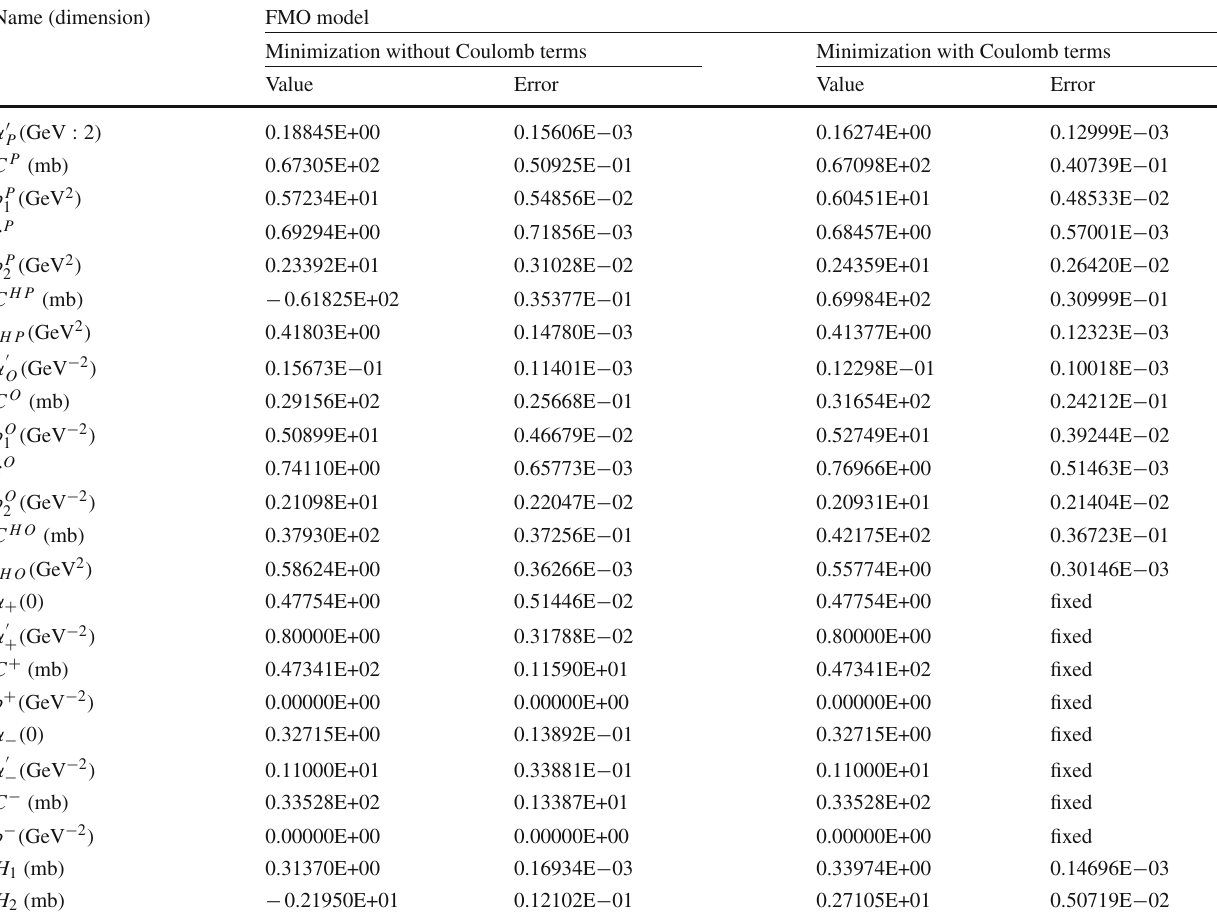
Table 3 Parameters of standard Pomeron and Odderon, of their double rescatterings, of secondary Reggeons and their errors in FMO model determined from the fits to the data on d σ/ dt . Total cross sections σ tot and ratios ρ were included in the fit without the Coulomb